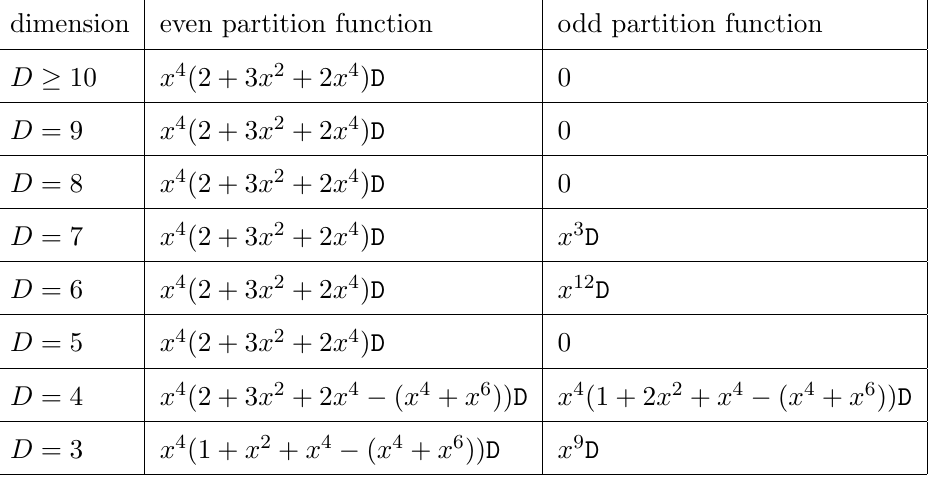
Table 1 . Final Result for the partition function over 4 photon S-matrices. Here D = 1